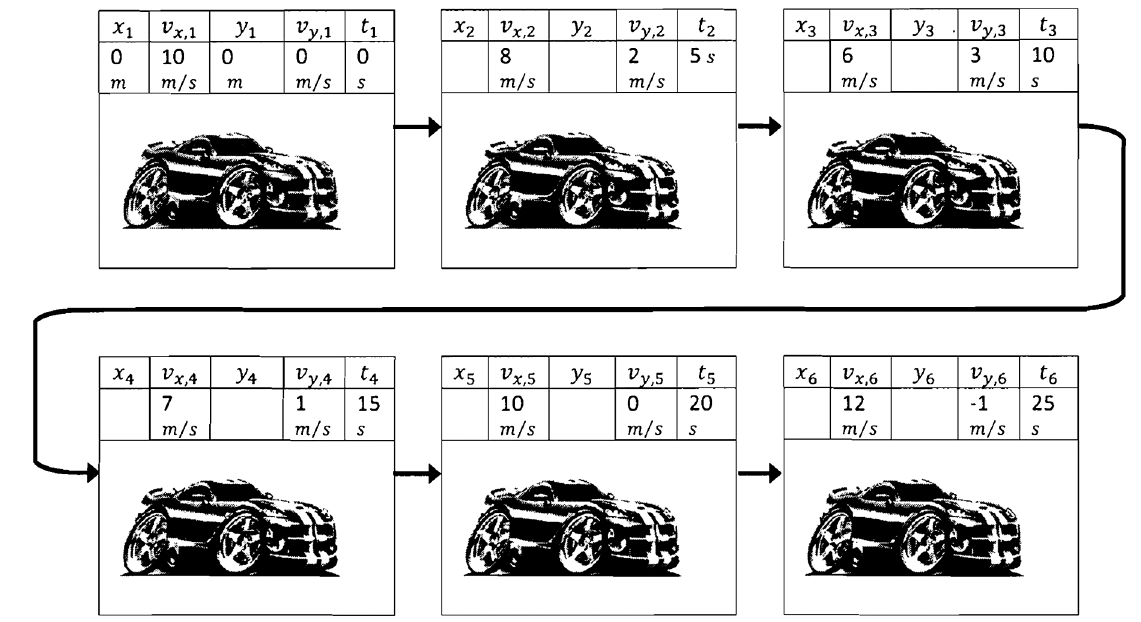
FIG. 6. ‘‘Sequence diagram’’ of a car used in lesson